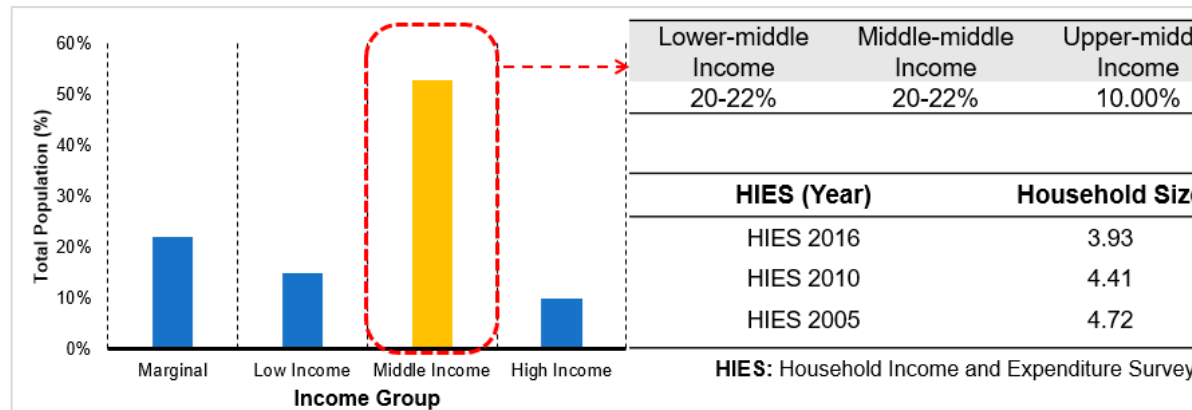
Figure 1. Different income groups in Dhaka City, Bangladesh. Source: [8,9,28]. According to the housing survey and BRAC reports in 2017, about 70–80 percent of middle-income families in Dhaka metropolitan areas are renters [8]. In Dhaka, house prices are increasing disproportionately compared to the housing needs of middle-income families [8,11,20]. Therefore, almost 70–78 percent of these middle-income families, particularly lower-middle and middle-income groups, cannot afford their own houses or apartments in the current market price of housing in Dhaka City, Bangladesh (Figure 2) [8,11,20,23].